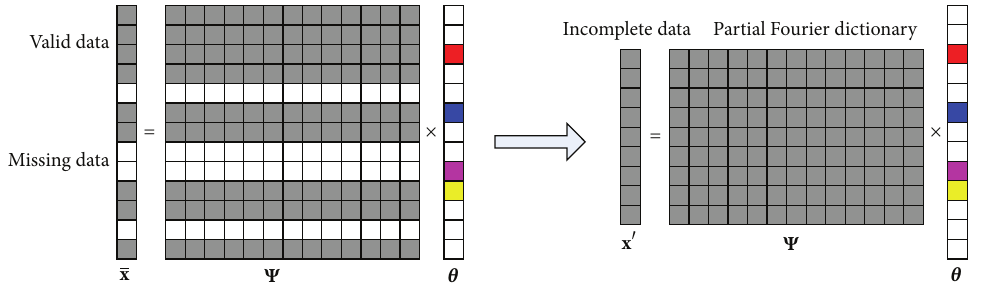
Figure 2: OTHR sparse signal geometry and dictionary